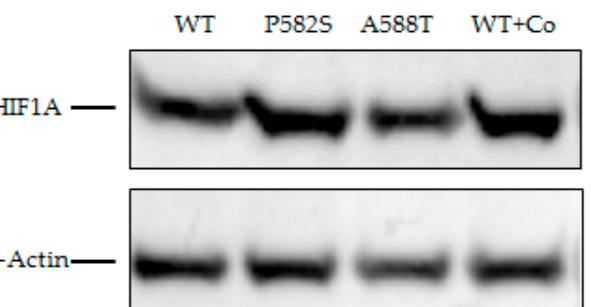
Figure 1. ( A ) Luciferase activity expressed as a fold change in the wild type (WT) and mutant vectors (P582S and A588T), as reported. ( B ) The HAMP mRNA levels expressed as the ratio between transfected and non-transfected Huh-7 cells under normoxic ( − ) and hypoxic (+) conditions. All data were obtained from three independent experiments done in triplicate.